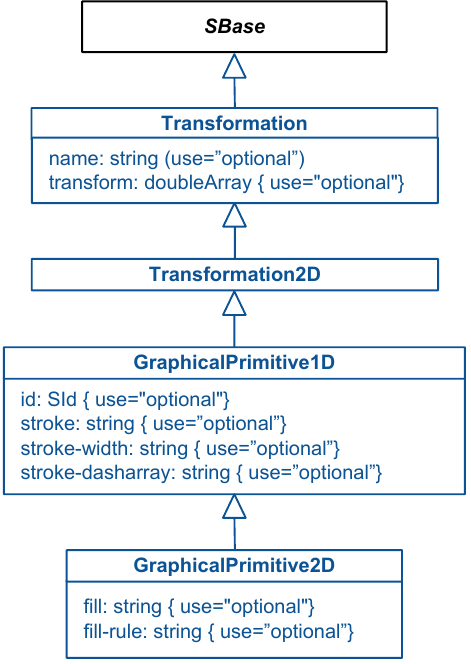
Figure 10: A UML representation of the base graphical primitive classes for the Render package. See Section 1.4 for conventions related to this